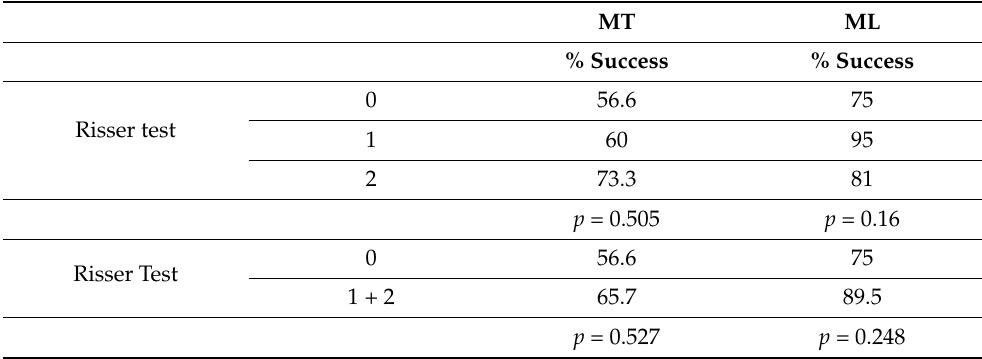
Table 3. Cross analysis of subgroup